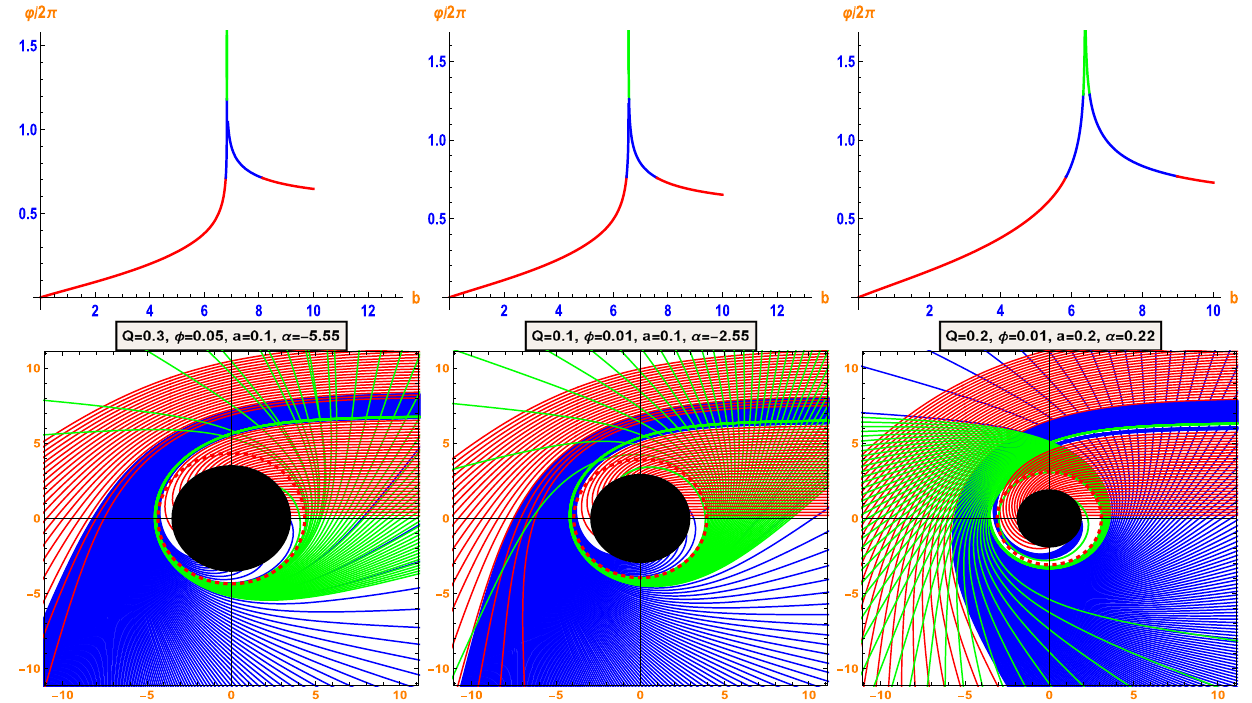
and green trajectories, respectively. The BH is shown as a solid black disk and the dashed red line represents the photon orbit and the mass of